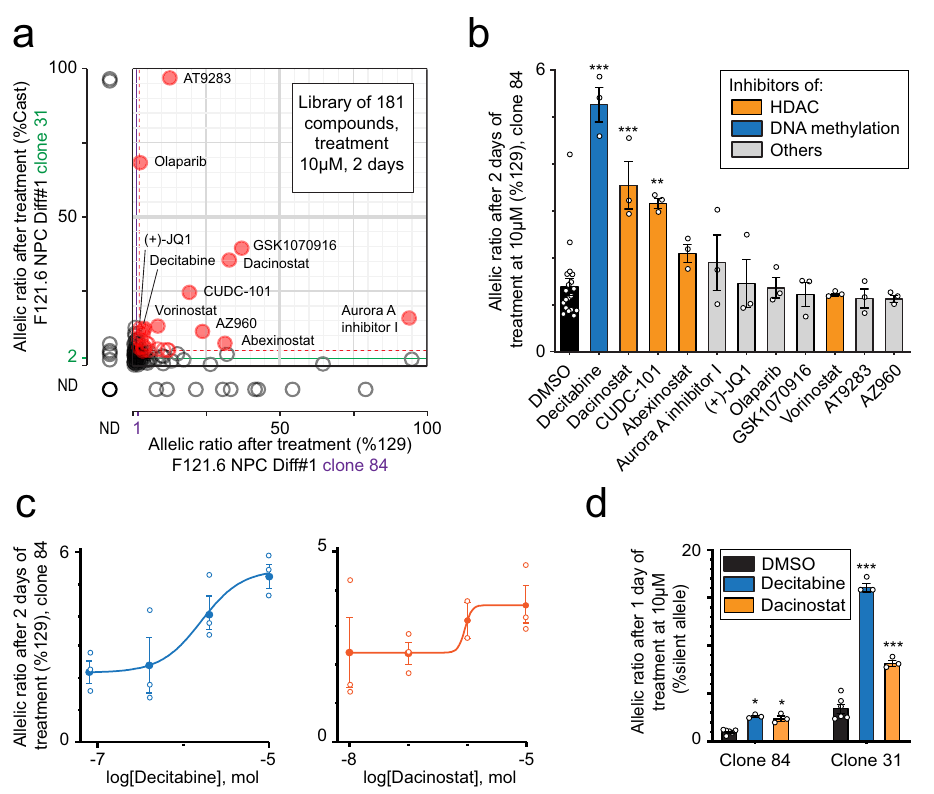
Fig. 8 Epigenetic maintenance of the monoallelic expression of Bag3. a Effect of treatment with an epidrug library (2 days at 10 µ M) on the allelic expression ratio of two NPC clones (#31 and #84), measured by pyrosequencing following RT-PCR. Purple and green lines represent the mean of the 11 controls, dashed red lines are mean + 3 x Stdev, red circles are compounds with an effect > mean + 3 x StDev for both clones. ND no data b Validation of three compounds among the 11 best hits from ( a ) on NPC clone #84 (2 days of treatment at 10 µ M). DMSO is used as the vehicle. Data were means ± SEM ( n = 3 replicates per condition). One ‐ way ANOVA: treatment effect, F (11,40) = 12, p < 10 − 4 . Dunnett ’ s post hoc test: * p < 0.05, *** p < 10 − 4 (DMSO versus treatment). c Dose-response curve for Decitabine and Dacinostat for NPC clone #84, after 2 days of treatment. Data were means ± SEM ( n = 3 replicates per condition). d Con fi rmation of the effect of Decitabine and Dacinostat on NPC clones #31 and #84, after 1 day of treatment at 10 µ M. DMSO is used as the vehicle. Data were means ± SEM ( n = 3 replicates per condition). Two ‐ way ANOVA: treatment effect, F (2, 18) = 200, p < 10 − 4 ; clone effect F (1,18) = 548, p < 10 − 4 ; interaction, F (2,18) = 120, p < 10 − 4 . Bonferroni post hoc test: * p < 0.05, *** p < 10 − 4 (DMSO versus